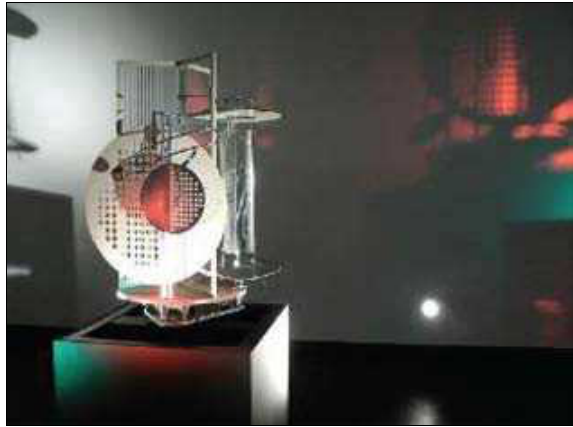
Fig. 4. Light-Space Modulator (arch. Lazlo Moholy-Nagy) , 1930